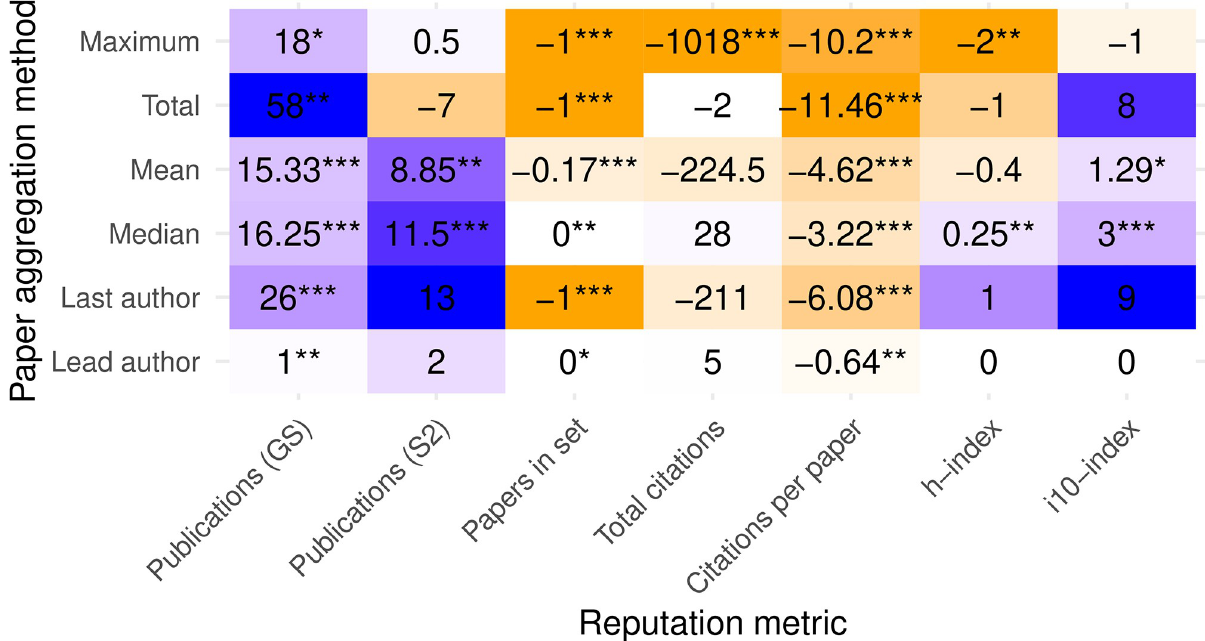
Fig 4. Difference in medians for various reputation metrics and aggregations across papers using two-sided Wilcoxon test. Positive values (purple) indicate higher reputation in SB conferences. Negative values (orange) indicate higher reputation in DB conferences. Darker colors reflect larger- magnitude values, normalized by columns. Stars indicate p values (from a Wilcoxon two-sided unpaired test) below 0.05, 0.01, and 0.001, respectively.